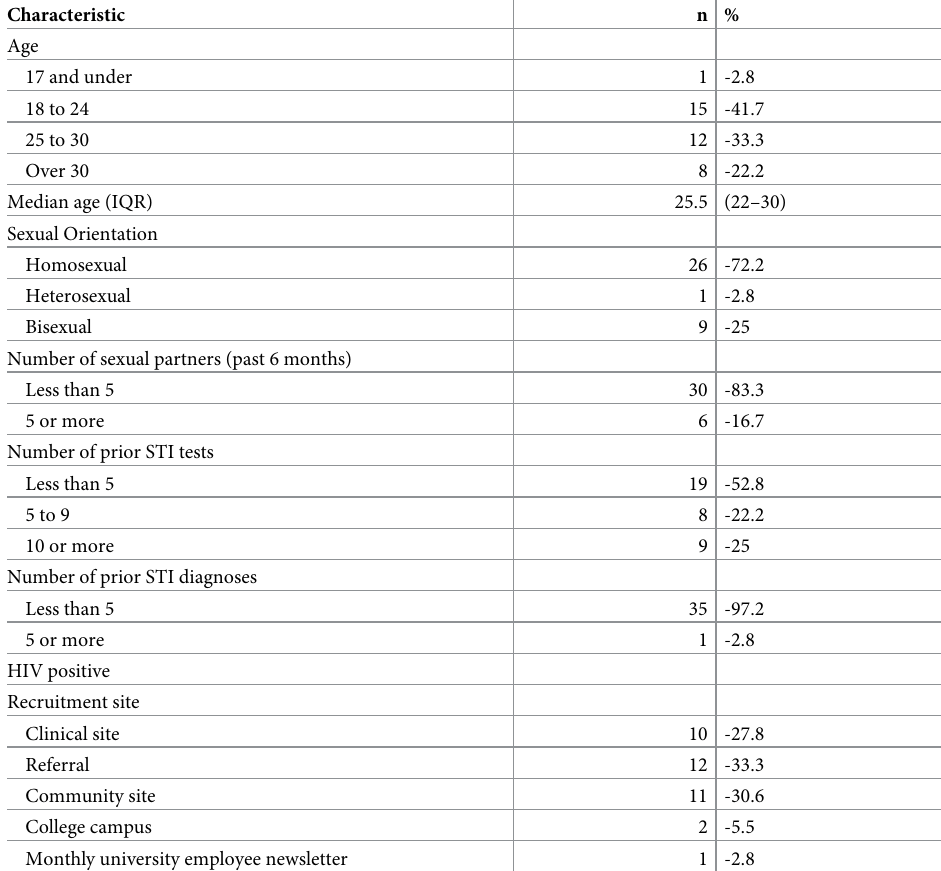
Table 1. Summary of YB MSM participating in an STI testing